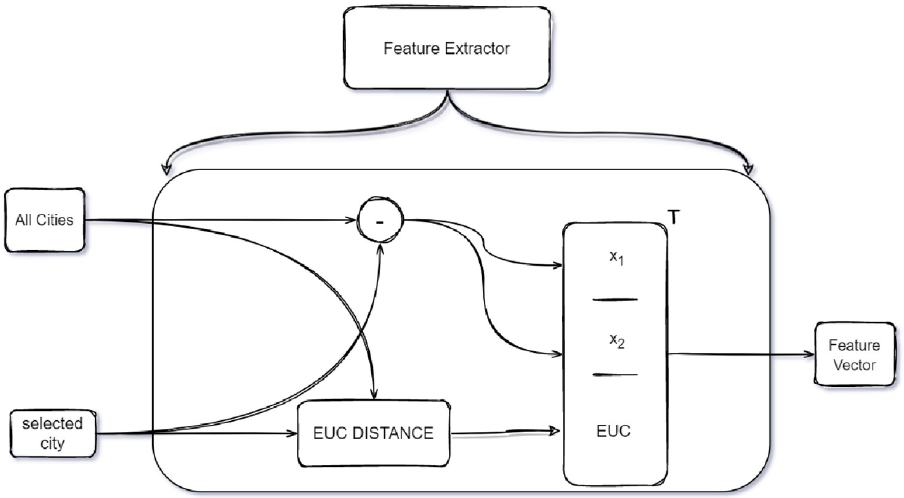
Fig 5. The feature extractor architecture combines both vector context with the Euclidian distance and outputs a Feature